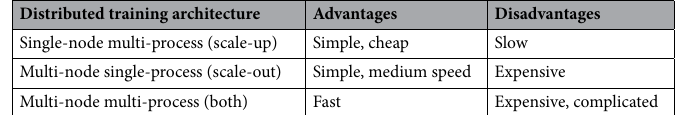
Table 4. The advantages and disadvantages of the various architectures.